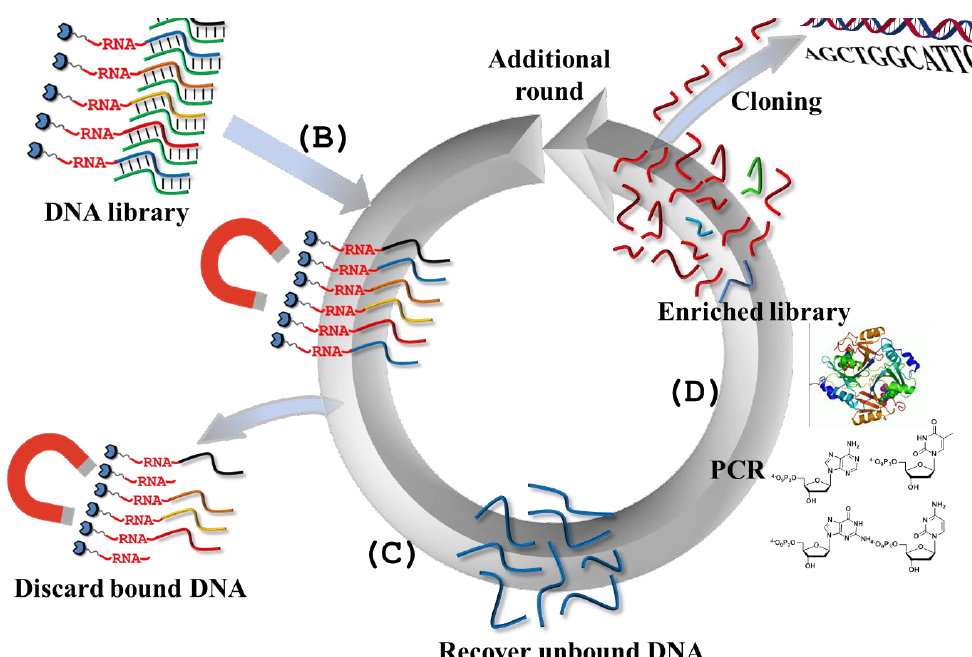
Figure 1. Overview of the selection scheme for the generation of RNA-cleaving DNAzymes: ( A ) oligonucleotides containing fixed-sequence regions (shown in blue) for the docking of the PCR primers and a central randomized region (in green) obtained by solid-phase synthesis, constitute the starting point for the generation of a randomized library either by PCR or by primer extension reaction. The primers often have biotin residues appended at their 5′-ends to enable immobilization of the oligonucleotide population and contain the RNA substrate; ( B ) the library is immobilized on a solid support (e.g., streptavidin-coated magnetic particles) and if necessary, the template strand is stripped off by a hydroxide treatment; ( C ) the immobilized population of oligonucleotides is subjected to the reaction conditions, and only the catalytically active species will be separated from the solid support and eluted; ( D ) the eluted sequences are PCR amplified and used in a subsequent round of selection. Adapted from reference [15].